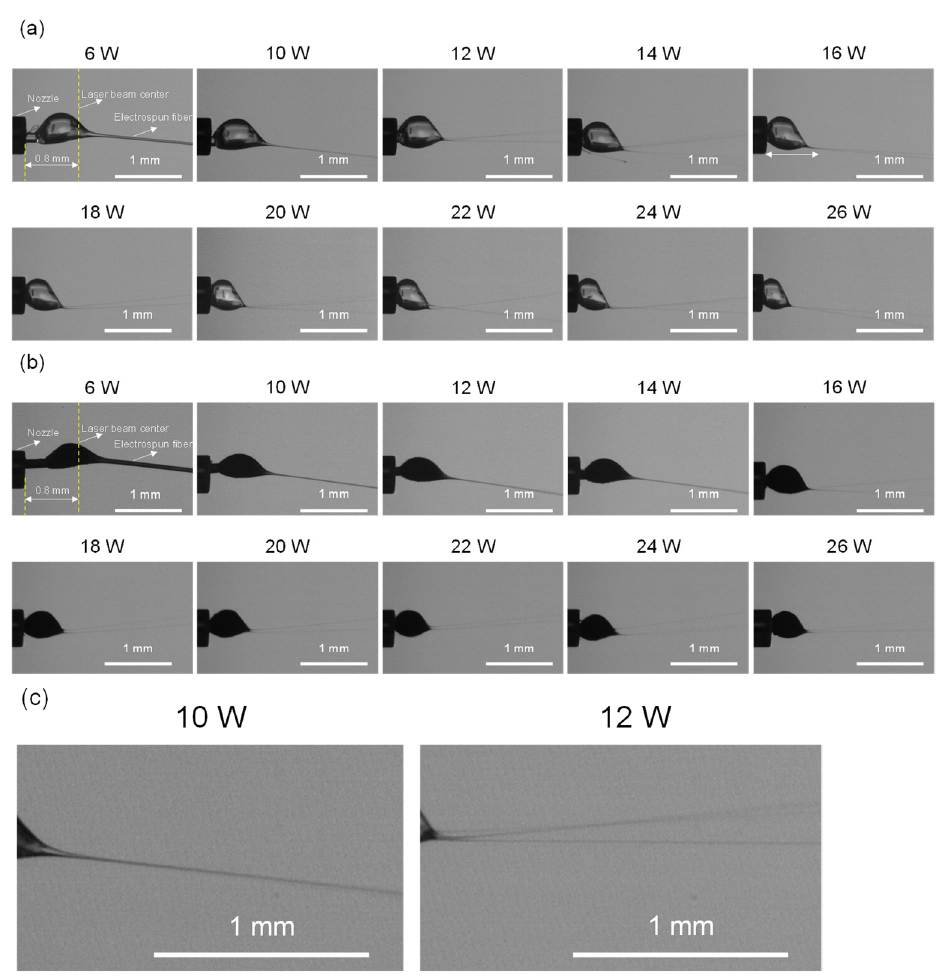
Figure 2. Images of the thinning behaviors ( a ) poly-(L-lactide) (PLLA), ( b ) bamboo charcoal (BC)/PLLA fibers near the nozzle at laser powers of 6–26 W. ( c ) Enlarged images for the PLLA spinning at laser powers of 10 W (single jet) and 12 W (multiple jet) are also shown.